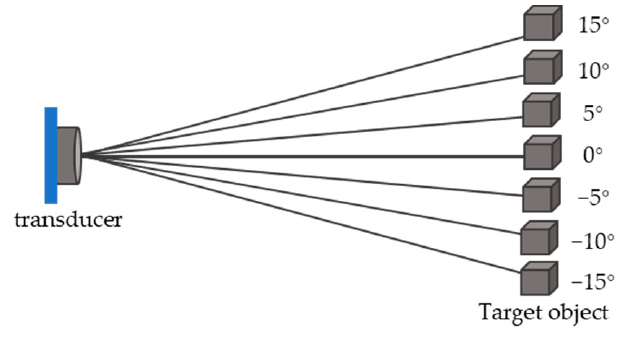
Figure 24. Angular range of target object detection.